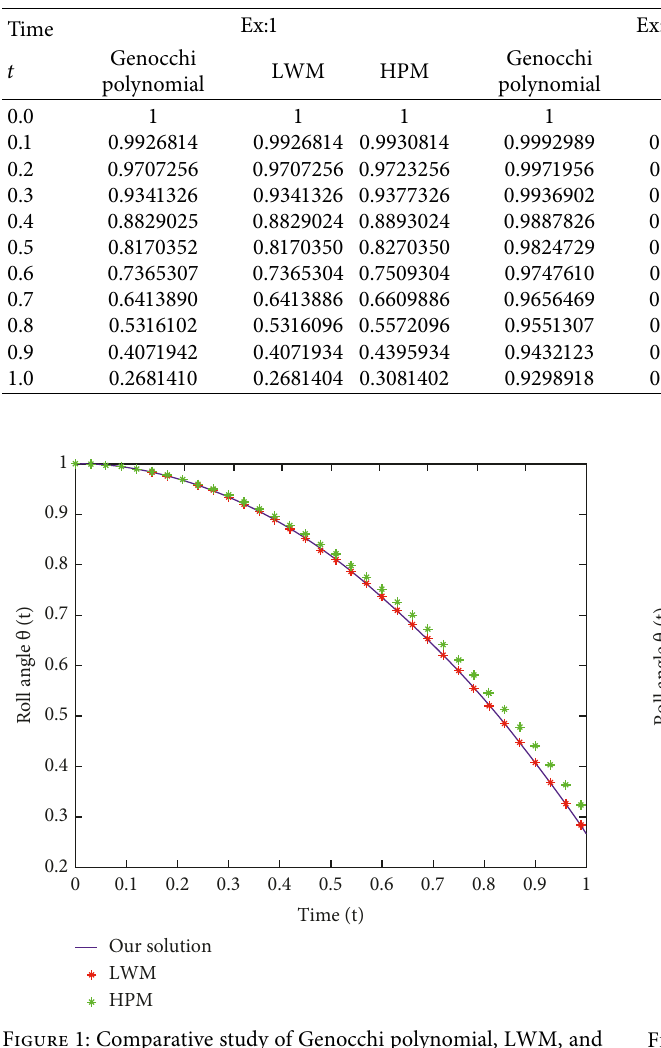
Figure 2: Comparative study of Genocchi polynomial, LWM, and HPM for roll angle with respect to the time t (in sec) for